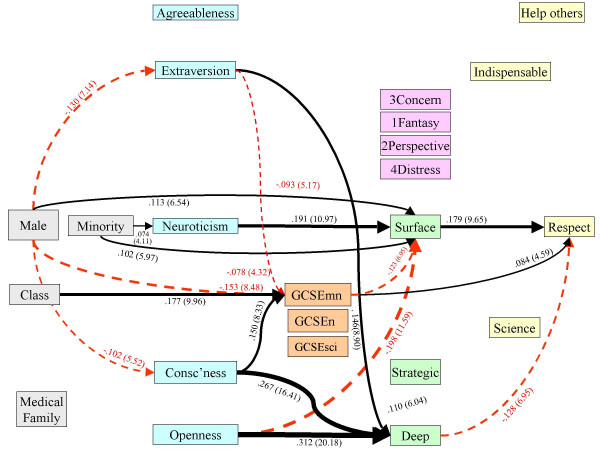
A reduced version of figure 1 in which the only paths shown are those with direct or indirect influences upon generic motivational factor (Respect). All variable names have been left in the diagram, and are in the same positions as in figure 1.